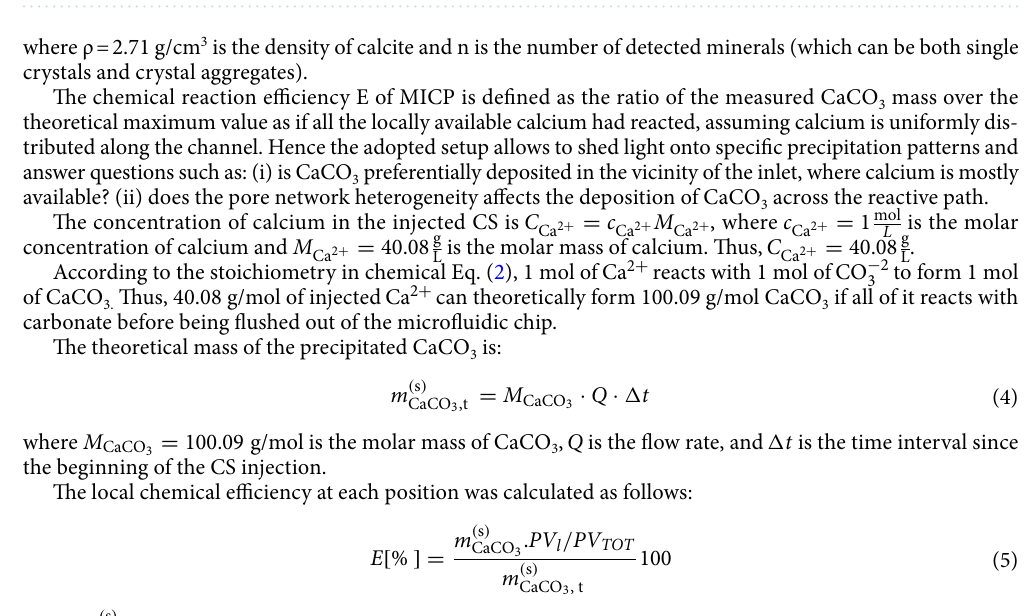
Figure 6. ( a ) Bacterial concentration of S. pasteurii at the beginning of CS injection (t = 0); ( b ) at t = 12 h across the meter-long reactive path. Dots represent averages of the triplicates; shaded areas represent the mean absolute deviation of the